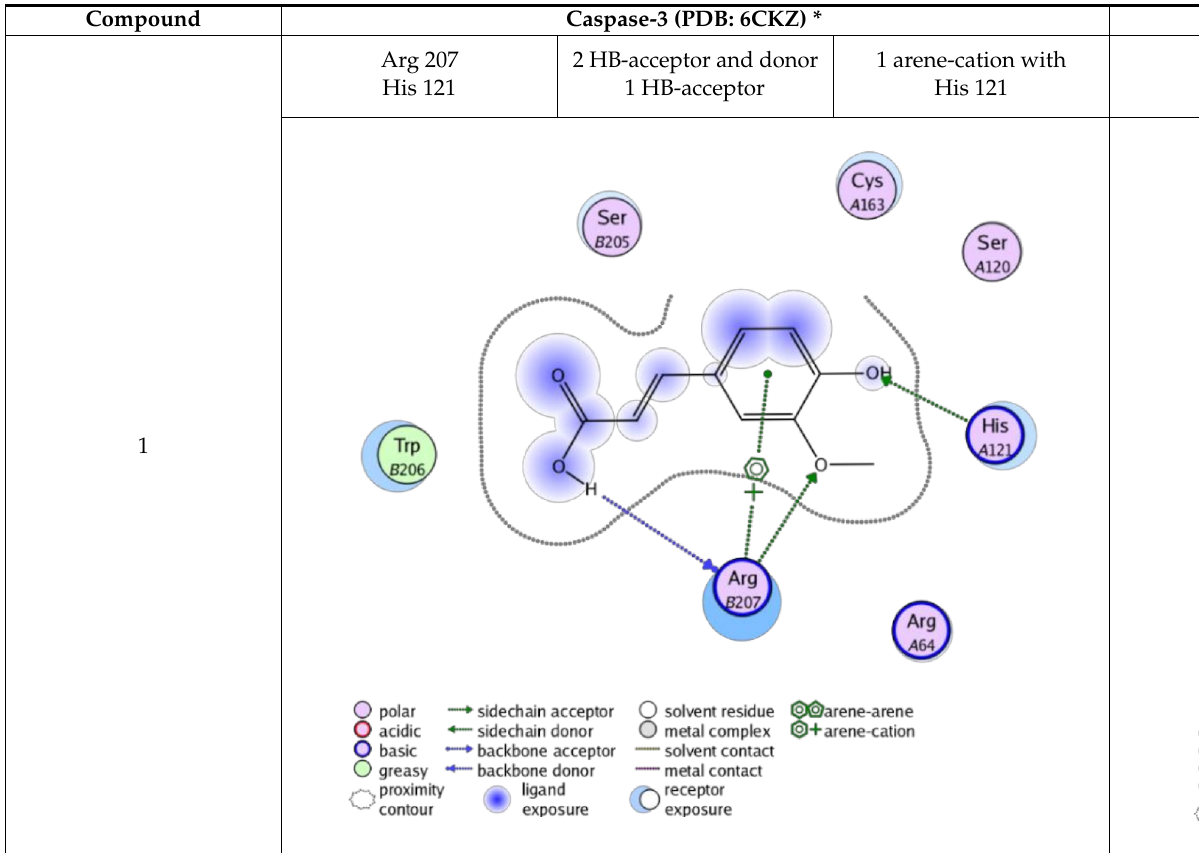
Table 4. Summary of ligand-receptor interactions of the five docked compounds inside the active site of caspase-3 (PDB: 6CKZ) and IFN- γ protein (PDB: